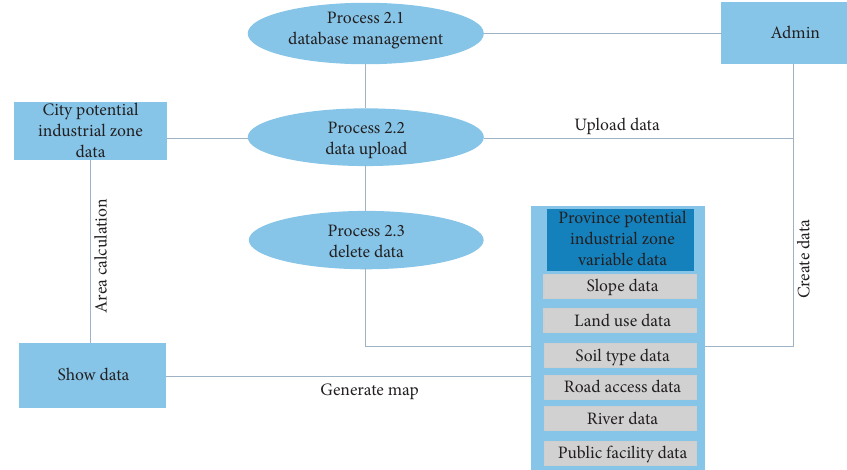
Figure 5: Data flow diagram data management (DFD level 1).